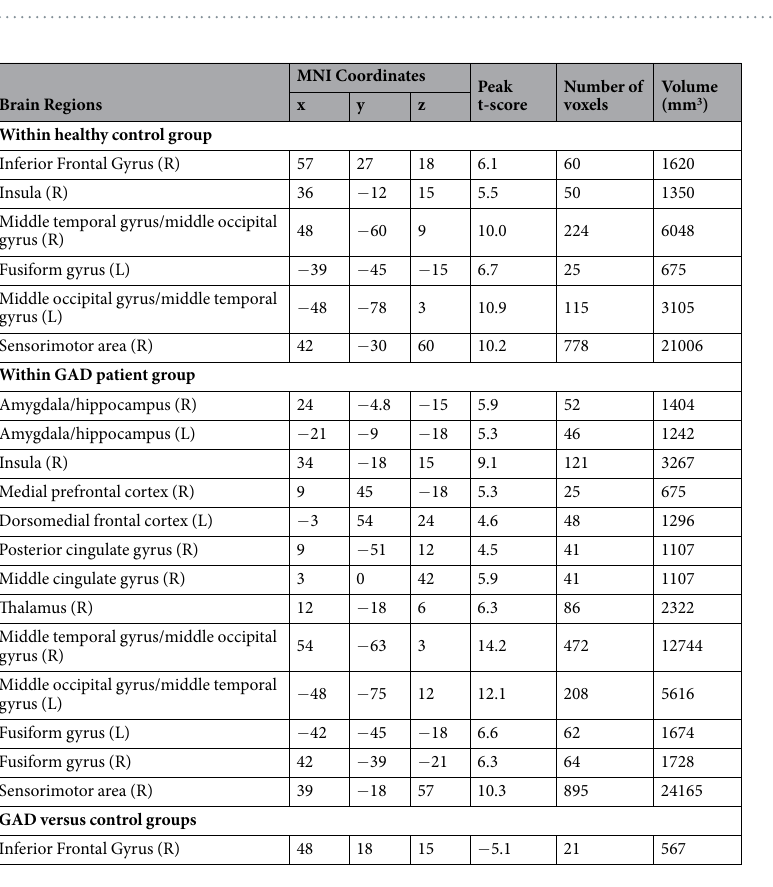
Table 2. Brain activation in response to negative versus neutral stimulus processing. Note: GAD = generalized anxiety disorder, L = left, R = right. For the group-wise analysis, the threshold was set at p < 0.05, AlphaSim corrected (i.e., p-voxel < 0.0005 with minimum cluster size = 22 voxels). For the Between-group analysis, we considered p < 0.05, AlphaSim corrected (i.e., p-voxel < 0.001 with minimum cluster size = 12 voxels) to be statistically